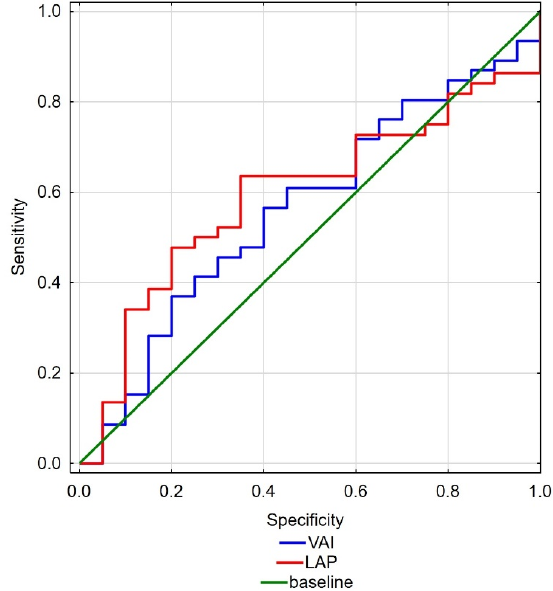
Figure 2. Receiver operating characteristics of the concentrations of VAI (blue line) and LAP (red line) for the International Index of Erectile Function.